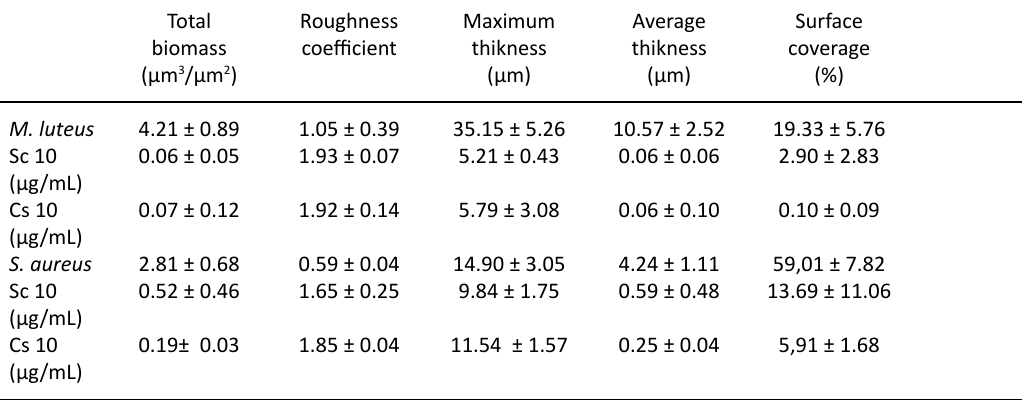
Sc: Salvia chudaei extract, Cs: Cymbopogon schoenanthus extract. Values represent means ±